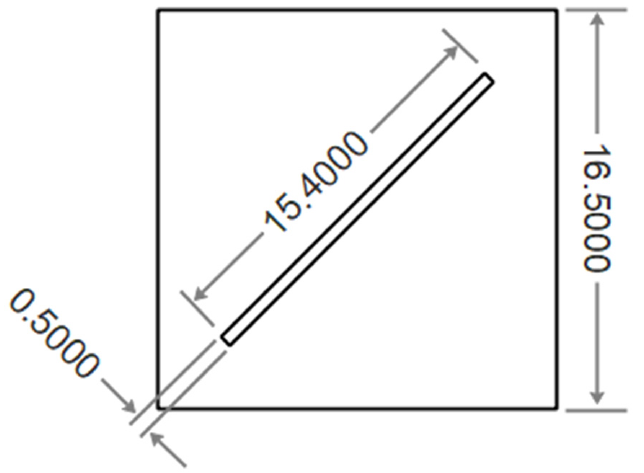
Figure 2. Schematic diagram of the flat membrane module with a diagonal channel for the air flow (dimensions in cm).